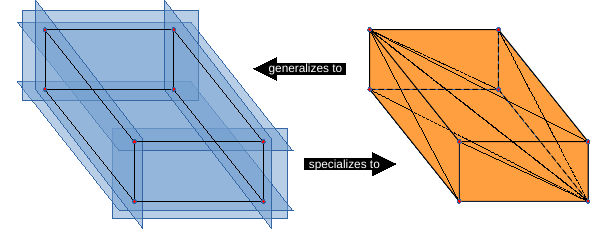
Figure 7. abstraction relation; BLUE: topologically inconsistent Triangle3DNet object made off six Triangle3DComponent objects; BLACK: surface intersections (left) triangle borders (right); ORANGE: Tetrahedron3DComponent object as result of the